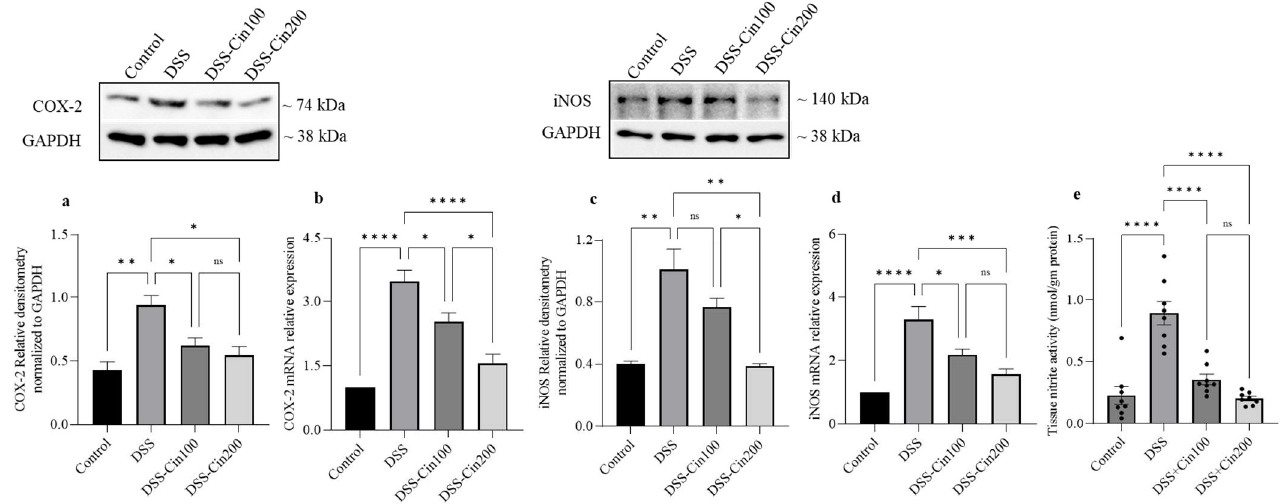
Figure 5. Effect of 1,8-cineole on COX2 and iNOS protein and mRNA expression as well as tissue nitrite levels. ( a , c ) The upper panel shows COX2 and iNOS protein expression by Western blot. A representative of protein bands that were normalized to GAPDH protein as an internal control is shown. Densitometry analysis shows that DSS administration significantly increased ( a ) COX2, ( c ) iNOS protein, and ( b , d ) mRNA expression. In contrast, 1,8-cineole treatment significantly prevented the increases in protein and mRNA expression. ( a – d ) DSS treatment increased tissue nitrite levels, while ( e ) 1,8-cineole treatment prevented this. Data were obtained from n = 4 animals/group. The results are expressed as the means ± SEM. * p ≤ 0.05, ** p ≤ 0.01, *** p ≤ 0.001, **** p ≤ 0.0001, and ns indicates results that were not significant.